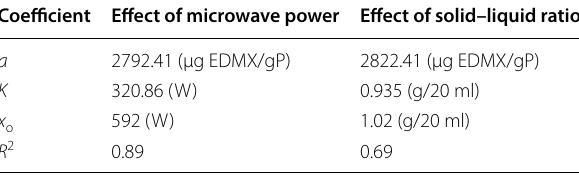
Table 3 Gaussian model of microwave-assisted extraction of xanthones Coefficient Effect of microwave power Effect of solid–liquid